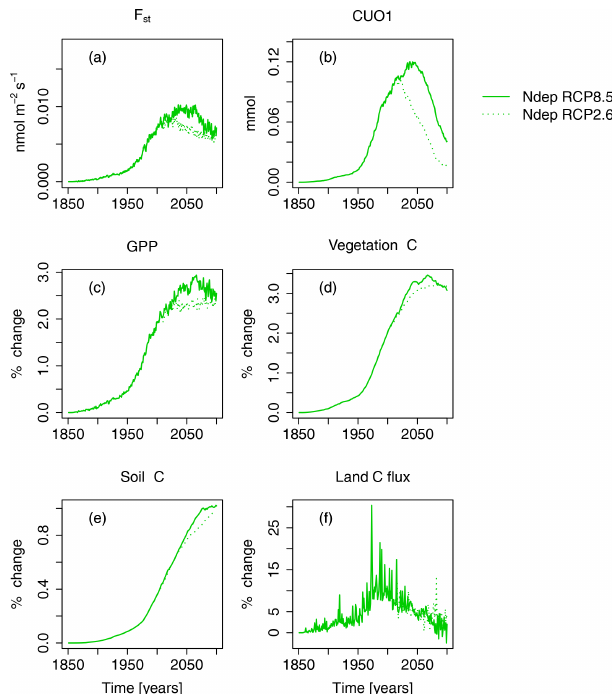
Figure 5. Nitrogen deposition induced absolute change in regional mean O 3 uptake ( F st ), mean cumulative O 3 uptake above a flux threshold of 1nmolm − 2 s − 1 (CUO1), and change in percent of summed GPP, summed carbon biomass (vegetation C), summed carbon soil organic matter (soil C), and summed land carbon flux (land C flux) compared to preindustrial values in the simulation region. The nitrogen-deposition-induced change is calculated from the simulation runs S3 and S5 (see Table 2). Solid lines indicate re- sults from simulations based on RCP8.5, and dotted lines are results from simulations based on RCP2.6. The effect of the seasonal cycle is smoothed by the application of a moving average of 12 months (a, b) .